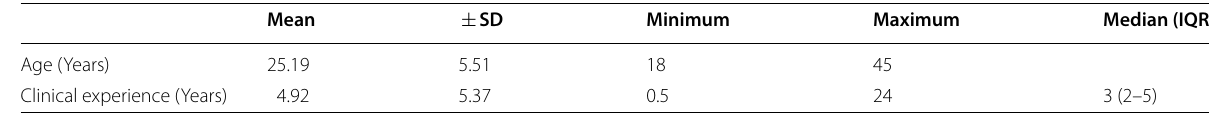
Table 1 Description of participants’ socio-demographic characteristics